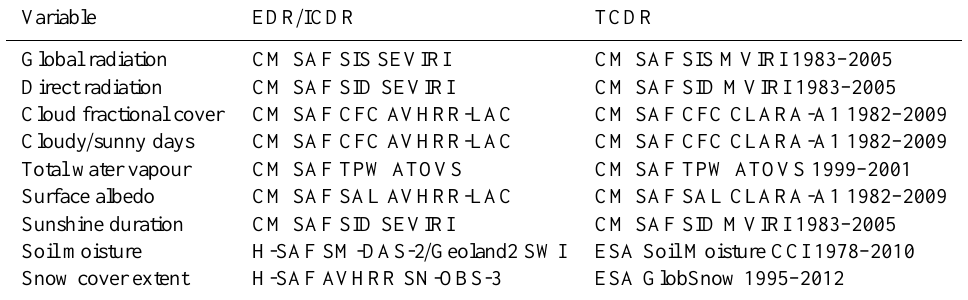
Table 1. RCC-CM satellite-based climate variables and corresponding input data sets (EDR – environmental data record, ICDR – interim climate data record, TCDR – thematic climate data